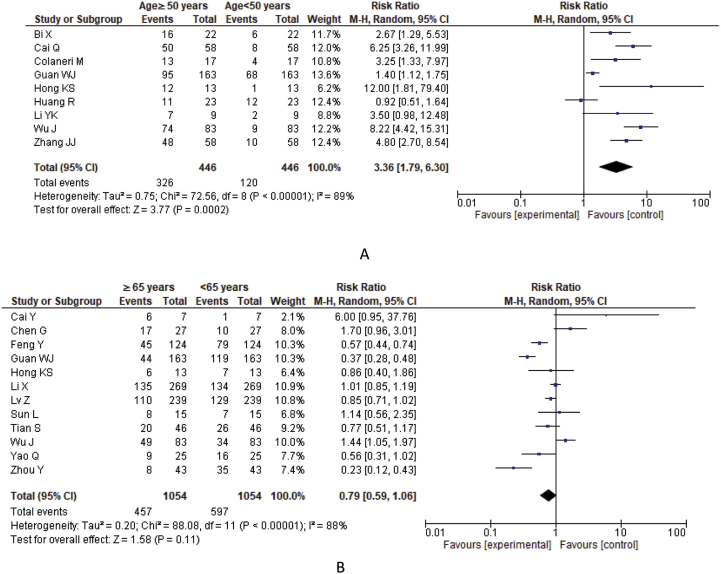
Meta-analysis for the effect of age on the severity of COVID-19 cases. Forest plots depict the comparison of the incidences of A) age ≥50 vs. age<50 years B) age ≥65 vs. age<65 years in severe patients.